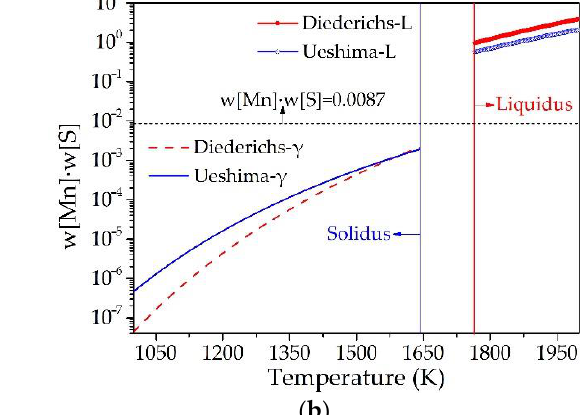
Figure 8. Relationship between MnS inclusions and solidification structure in the slab of medium carbon structural steel 45# revealed by experimental observation. ( a , b ) microstructure, ( c – e ) element mapping results, ( f ) MnS inclusion observed between dendrites. 4.2. Mechanism of MnS Inclusion Aggregation The precipitation of MnS inclusions at the end of solidification is heavily dependent on the local sulfur content in the residual liquid and the secondary dendrite arm spacing in different macrostructure zones. Therefore, the sulfur content and secondary dendrite arm spacing along the slab thickness of the 45# steel were measured. The comparison be- tween the measurement results and the area fraction of MnS inclusions is shown in Figure 9. Where S local /S average presents the segregation index of sulfur. The mixed zone is the key transformation region for not only the segregation index of sulfur, but also the secondary dendrite spacing, and the area fraction of MnS inclusions. Generally, the segregation of sulfur gradually increases from negative to positive segre- gation along the slab thickness toward the center. The positive segregation index has the maximum value of 1.12 occurs in the slab center, and the second maximum value is 1.06 in the mixed zone near the loose side. In addition, there is a certain degree of negative segregation between the mixed zone and slab center. This is because the dendritic bridge formed in the mixed zone can hinder the flow of solute-rich liquid and promote enrich- ment and dilution of solute elements in the upper and lower parts of the dendritic bridge,